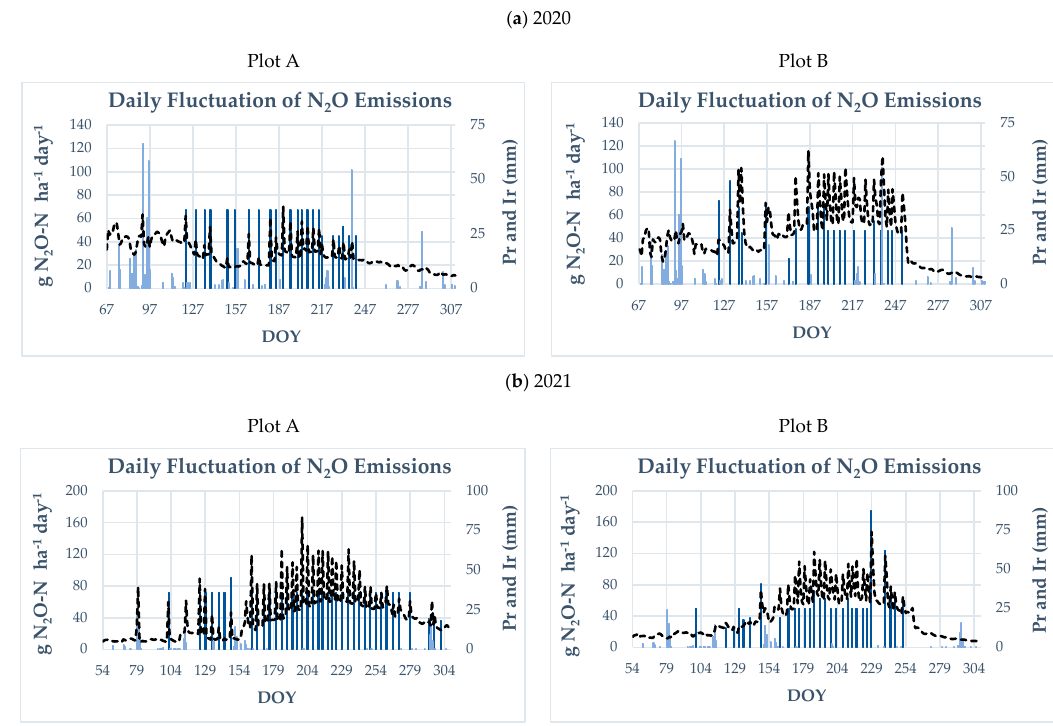
Figure 6. Daily fluctuation of nitrous oxide emissions in g N 2 O-N ha − 1 day − 1 , for plots A and B in ( a ) 2020 and ( b ) 2021; simulated by the CropSyst model. The blue bars show precipitation (Pr), whereas the dark blue bars show irrigation (Ir) water applied.